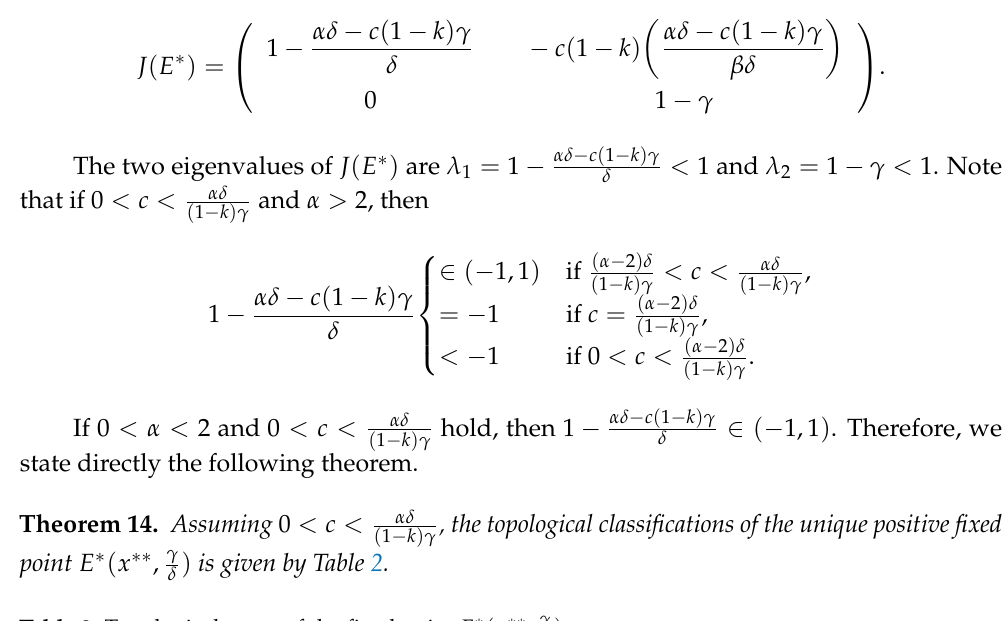
Table 2. Topological types of the fixed point E ∗ ( x ∗∗ , γ